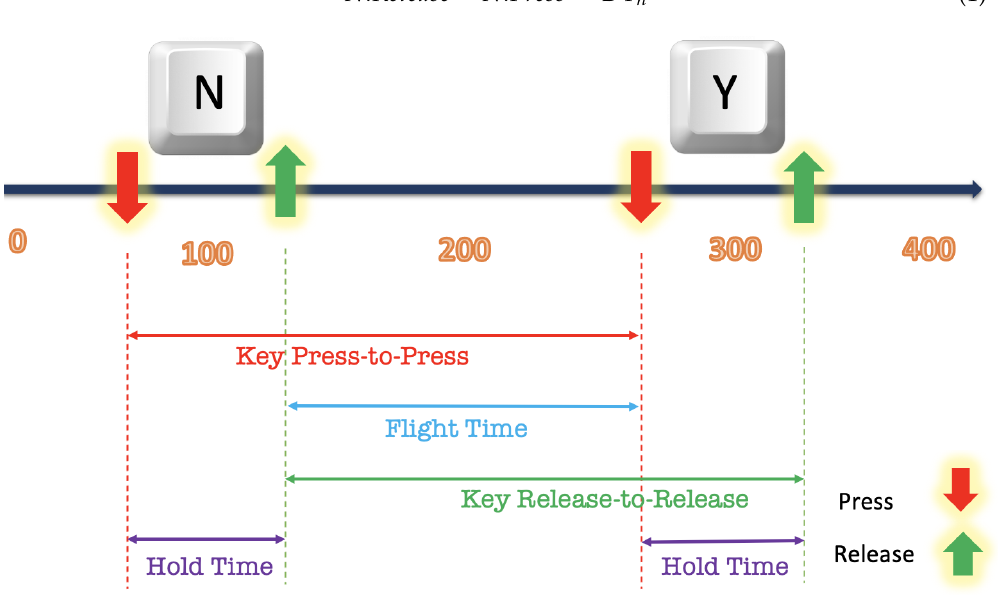
Figure 1. Time feature structure